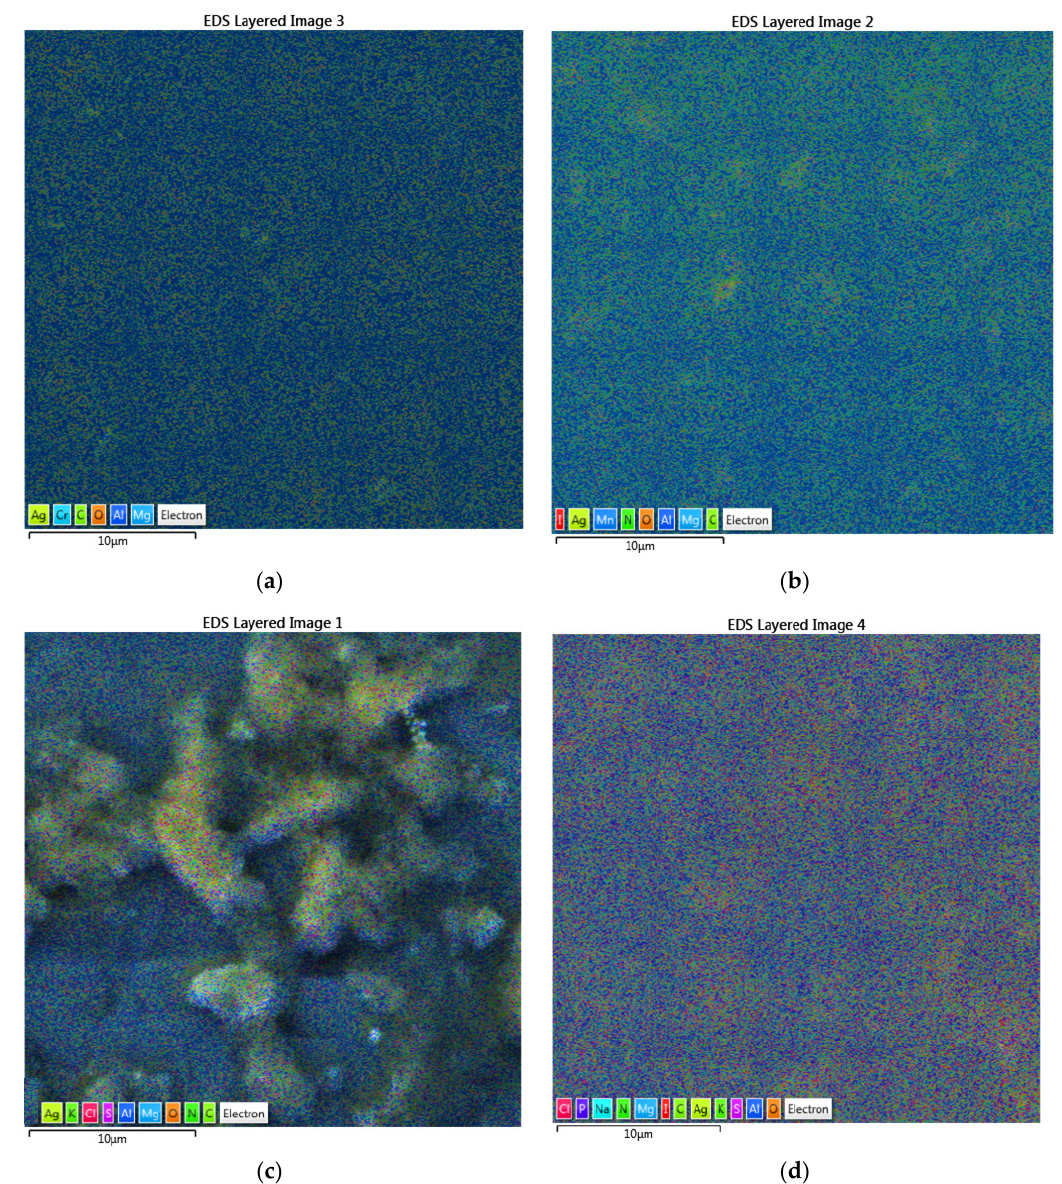
Figure 3. EDS layered images of the four samples. From up to down: ( a ) TCA-AgNP; ( b ) Cinn-AgNP; ( c ) TCA-AgNP-PI; ( d )